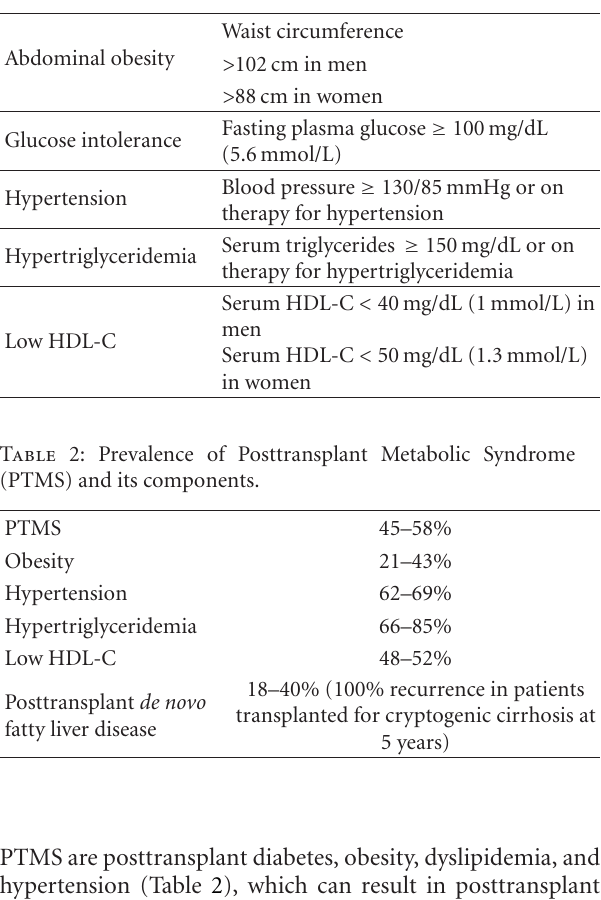
Table 1: National cholesterol education program: Adult Treatment Panel III criteria for metabolic syndrome.